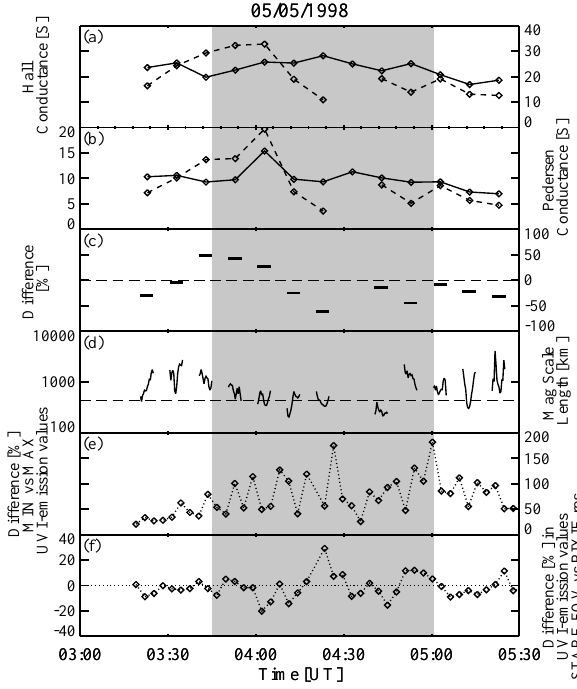
Fig. 3. (a) The Hall and (b) Pedersen conductances [S] derived in the Scandinavian region using UVI and PIXIE measurements (solid line) and the 1D method of characteristics (dashed line) on May 5, 1998. (c) The difference in between the two conductance sets. The horizontal dashed line is drawn to give the 0-percent level, while the length of the lines indicates the integration time period. (d) Magnetic field scale lengths [km] between the two MIRACLE magnetometer stations of AND and KEV. (e) The average percentage calculated using the lowest and largest UVI-LBHL emission values at five strips of constant latitude within the STARE FOV. (f) The difference in for the average UVI-LBHL intensity within the STARE FOV compared with the average UVI- LBHL intensity when including a larger area surrounding the STARE FOV matching the PIXIE resolution.